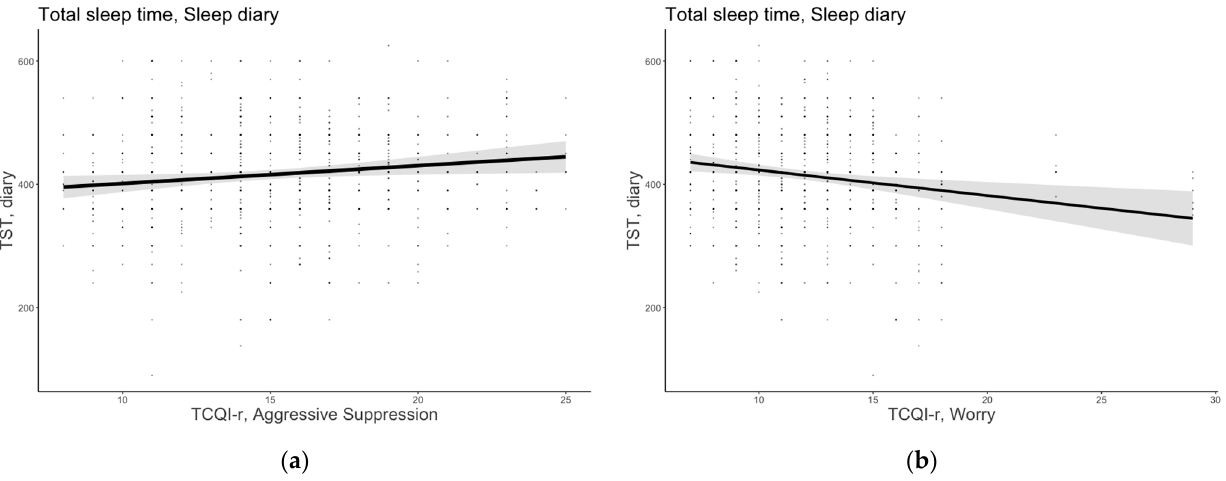
Figure 1. Subjective total sleep time as a function of ( a ) aggressive suppression and ( b ) worry strategies. The error bars represent 95% confidence intervals of the estimated means.